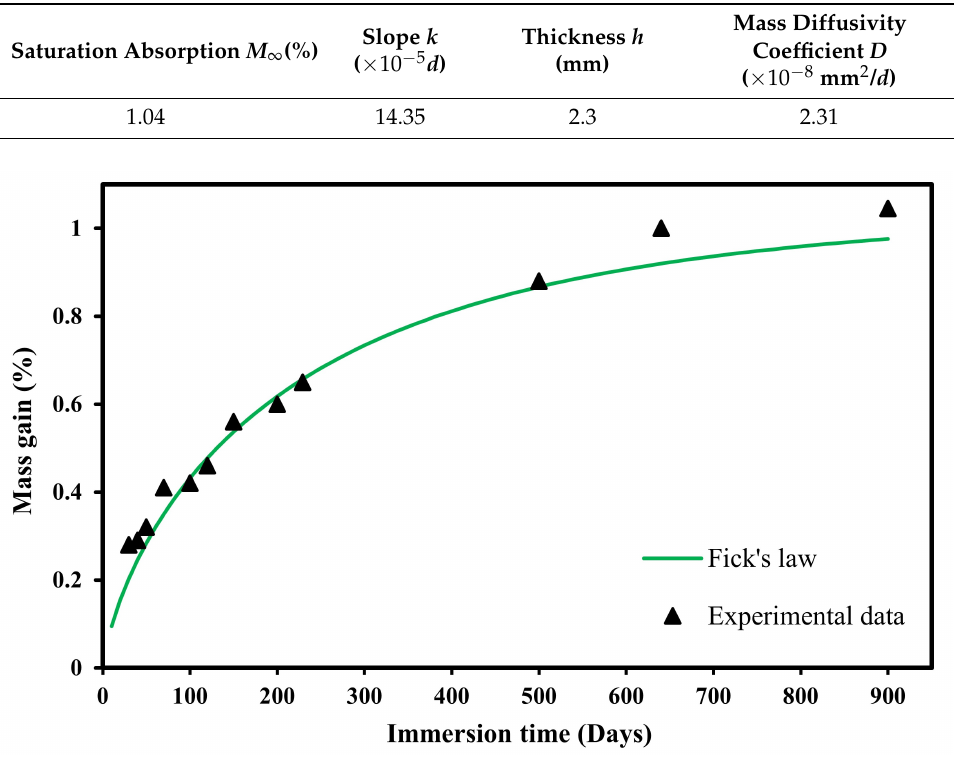
Figure 1. Comparison of Fick’s law for predicting the seawater absorption and the experimental results for the tested